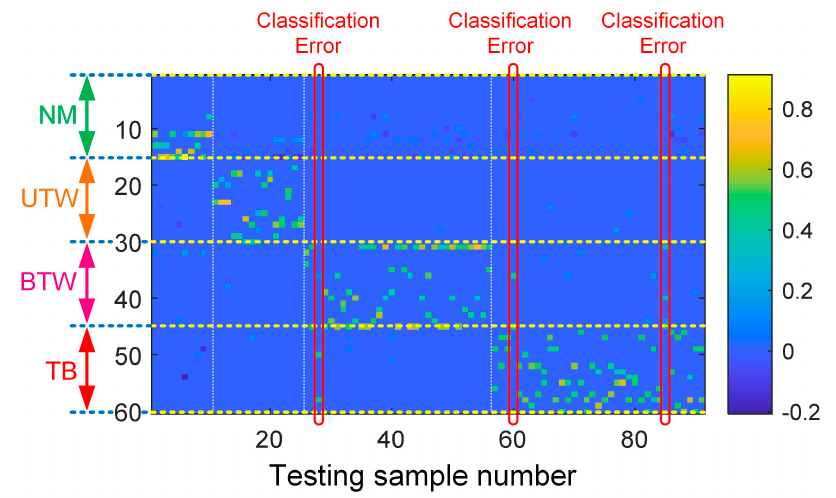
Figure 26. RPD: sparse vectors of testing samples.